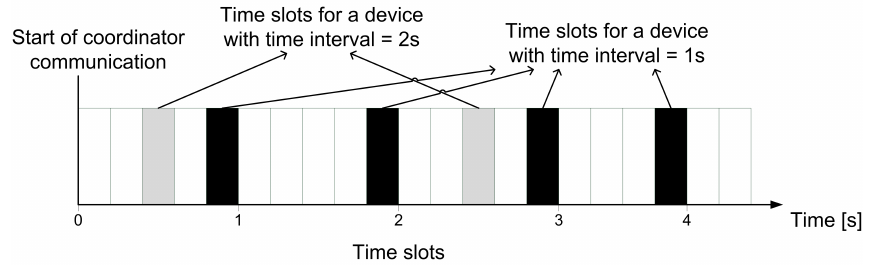
Figure 4. Time slots and time intervals example.